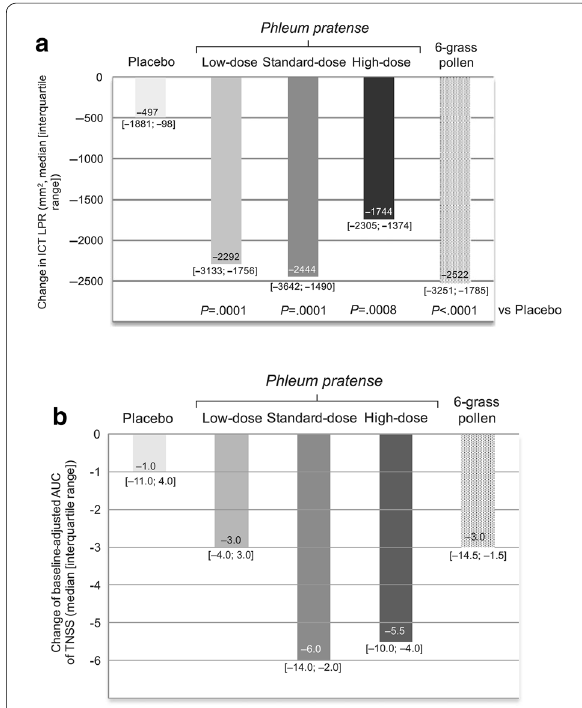
Fig. 2 Change in intracutaneous test (ICT) late phase reaction ( a ) and of baseline- adjusted area under the curve (AUC) of Total Nasal Symptom Score (TNSS) ( b ); reproduced from [48] with kind permission from